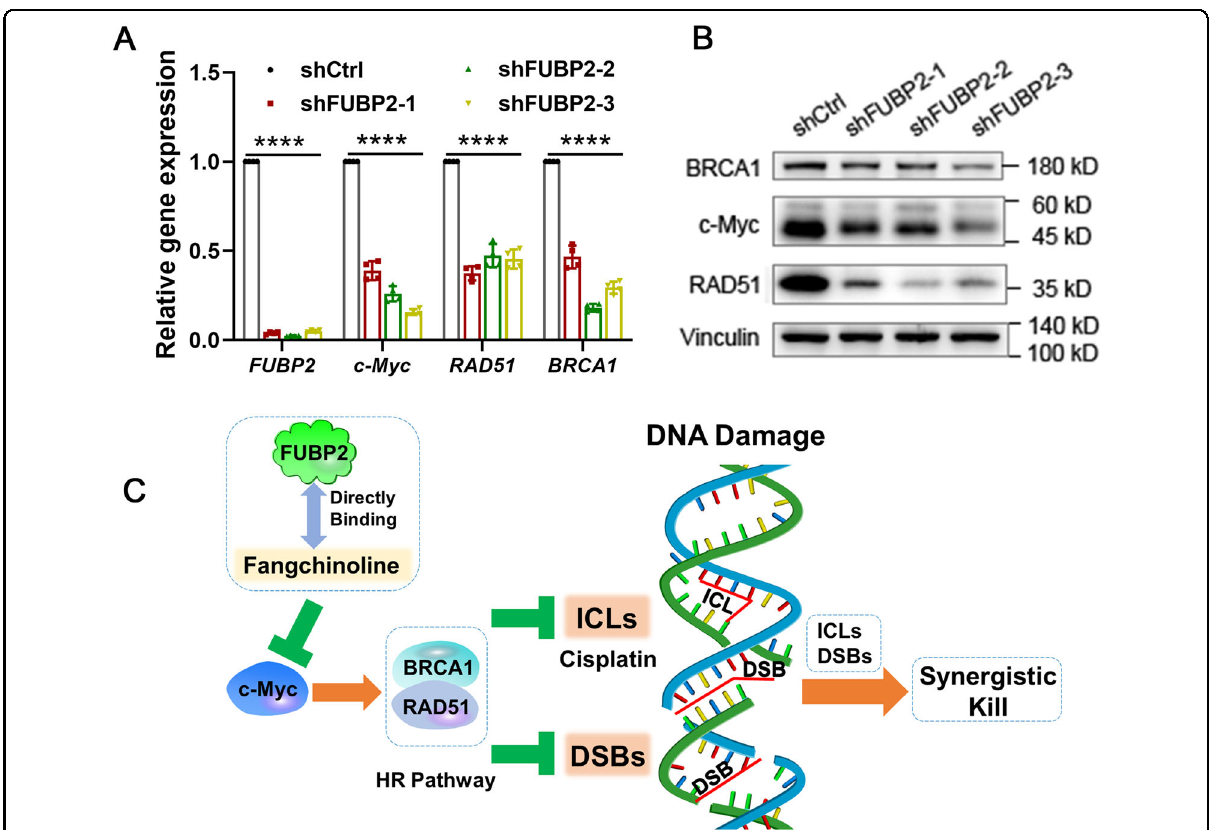
Fig. 5 Effects of FUBP2 on the HR pathway. A The transcriptional expressions of FUBP2 , c-Myc , RAD51 and BRCA1 were reduced after treatment with shFUBP2s in CM-AS16 cells. n = 4. B The protein expressions of c-Myc, RAD51 and BRCA1 were decreased in CM-AS16 cells after treatment with shFUBP2s. n = 3. C Schematic diagram of the action of fangchinoline in regulating the HR pathway. Data represent the mean ± SD of at least three independent experiments. * P < 0.05, **** P < 0.0001, by two-way